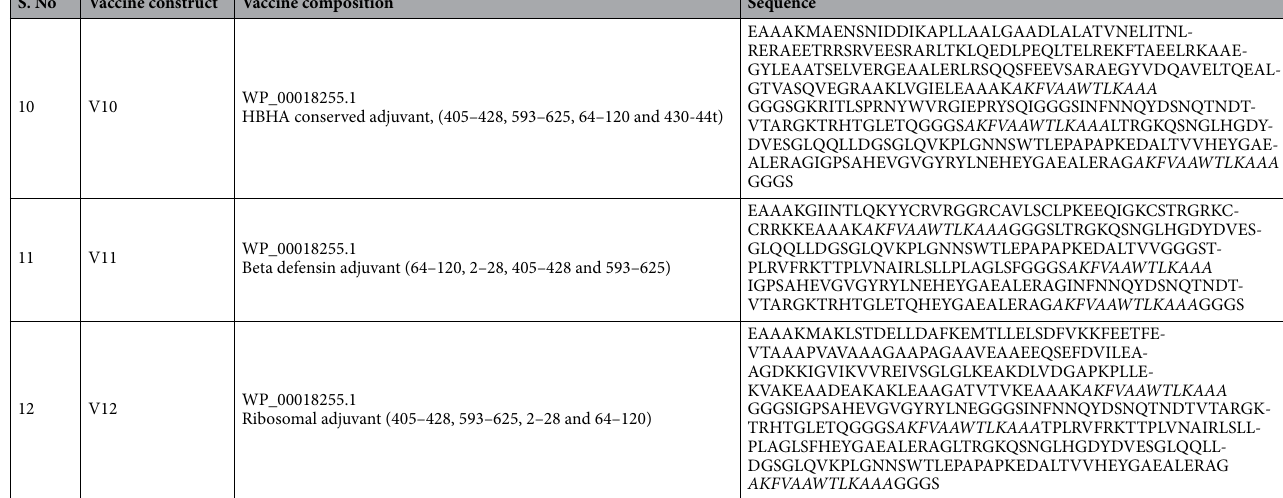
Table 4. Vaccine model constructs.